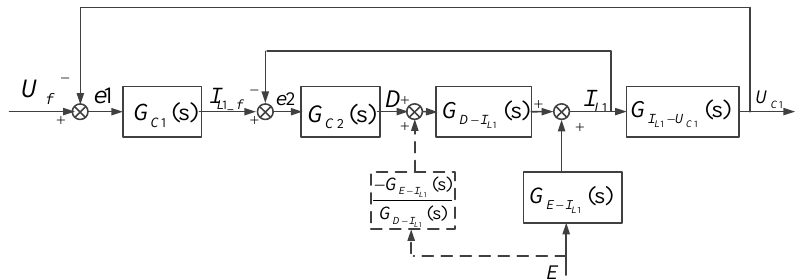
Figure 11. Block diagram of equivalent feedforward control.